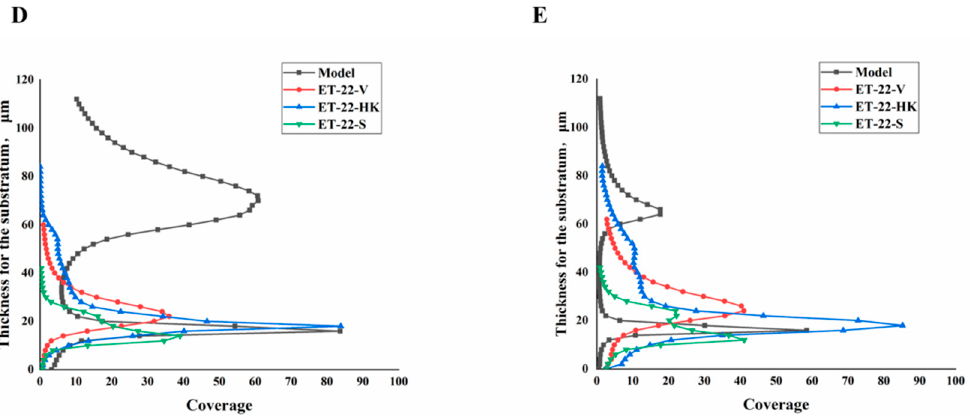
Figure 3. Effects of L. paracasei ET-22 on the thickness and biomasses of S. mutans biofilms. ( A ) Changes in thickness of the S. mutans biofilms after the co-culture with live bacteria (ET-22-V), heat-killed bacteria (ET-22-HK), and secretions (ET-22-S) of L. paracasei ET-22. Means ± SEM are shown ( n = 6). ** p < 0.01, vs. Model group. ( B ) The staining results of live and dead bacteria in S. mutans biofilms viewed using confocal laser scanning microscopy. ( C ) The biomasses of live bacteria (green) and dead bacteria (red) in S. mutans biofilms of the ET-22-V, ET-22-HK, and ET-22-S groups. N01 was used for the nuclear staining of live bacteria. Propidium iodide (PI) was used for the nuclear staining of dead bacteria. Means ± SEM are shown ( n = 6). ** p < 0.01, vs . live bacteria in the Model group. ( D , E ), the gathering positions of living bacteria ( D ) and dead bacteria ( E ) above the bottom of hydroxyapatite discs.